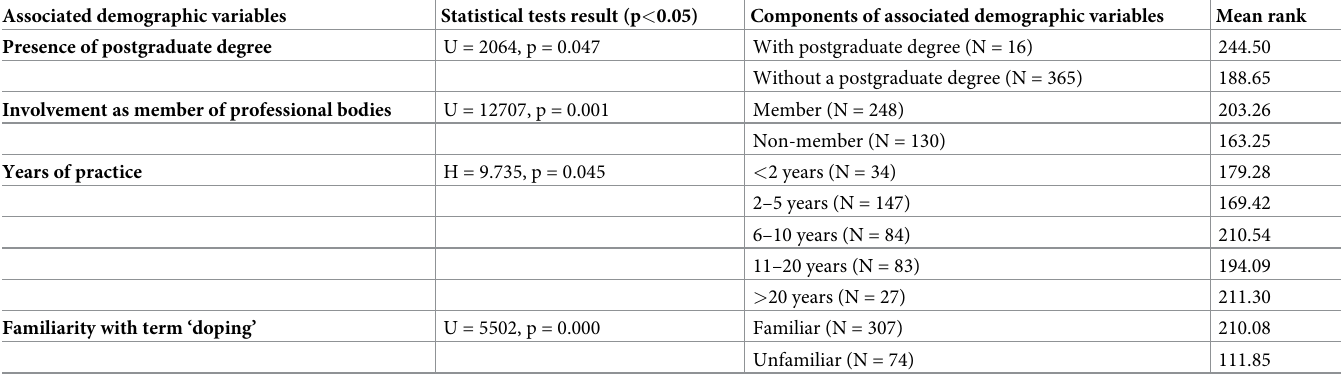
Table 5. Comparison of mean rank between associated demographic variables and total score of community pharmacists’